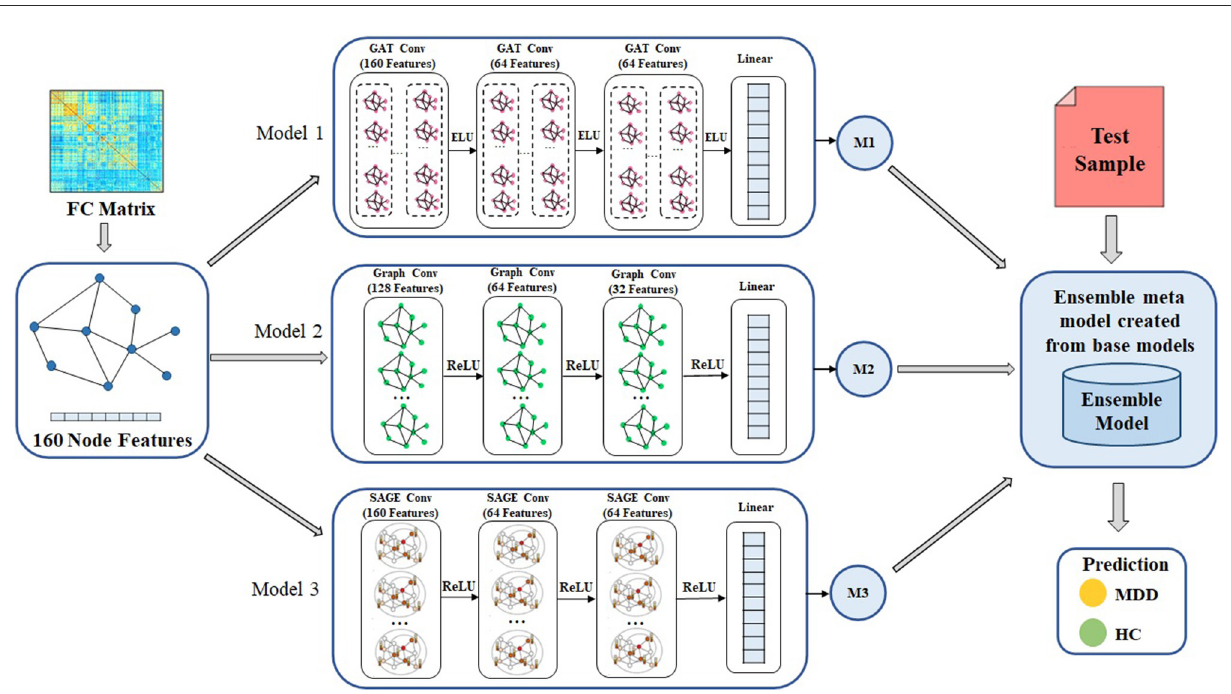
FIGURE2 Overall framework of the proposed method for MDD classification. Ensemble model is designed to create meta model from the out features of each base models. GAT, graph attention network; GCN, graph convolutional network; SAGE, GraphSAGE technique, ReLU, Rectified Linear Unit; ELU, Exponential Linear Unit, MDD, major depressive disorder; HC, healthy